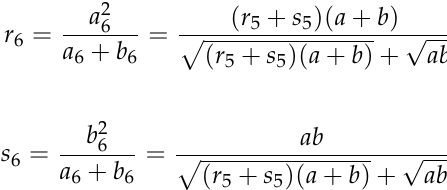
Figure 8. Geometric constructions of r 5 = a 4 Figure 8: Geometric constructions of r and s = b 2 . a + b s = b 2 . a + b